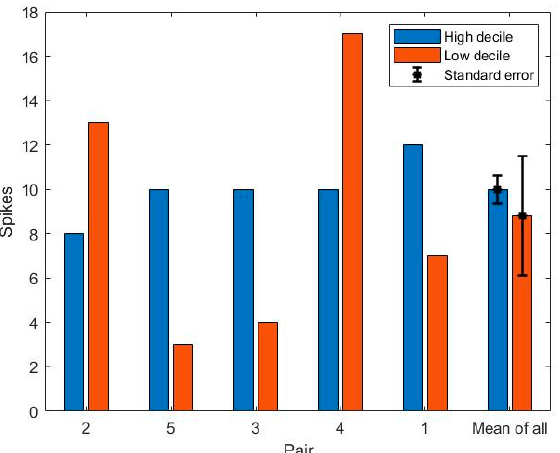
Figure 13. The number of spikes in PNC observed for each pair of routes.